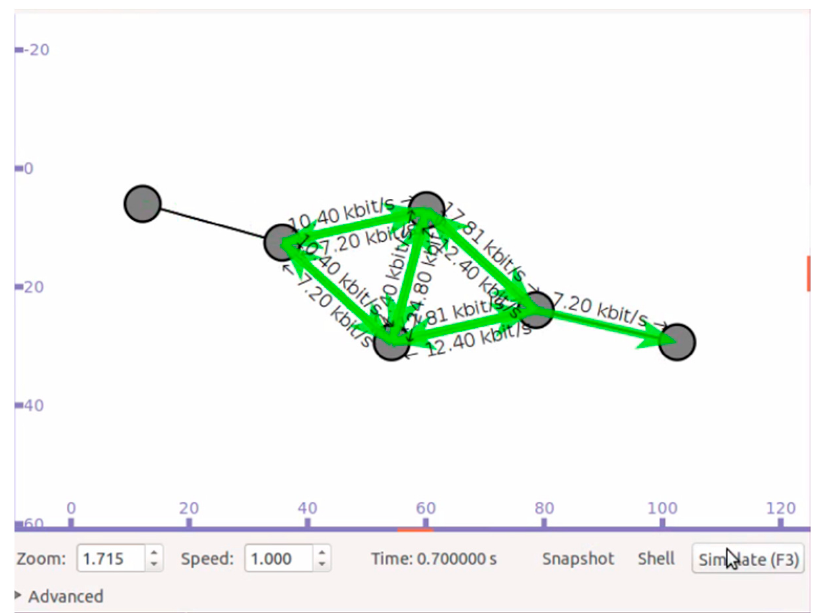
Figure 6. The process of simulation testing fault tolerance.